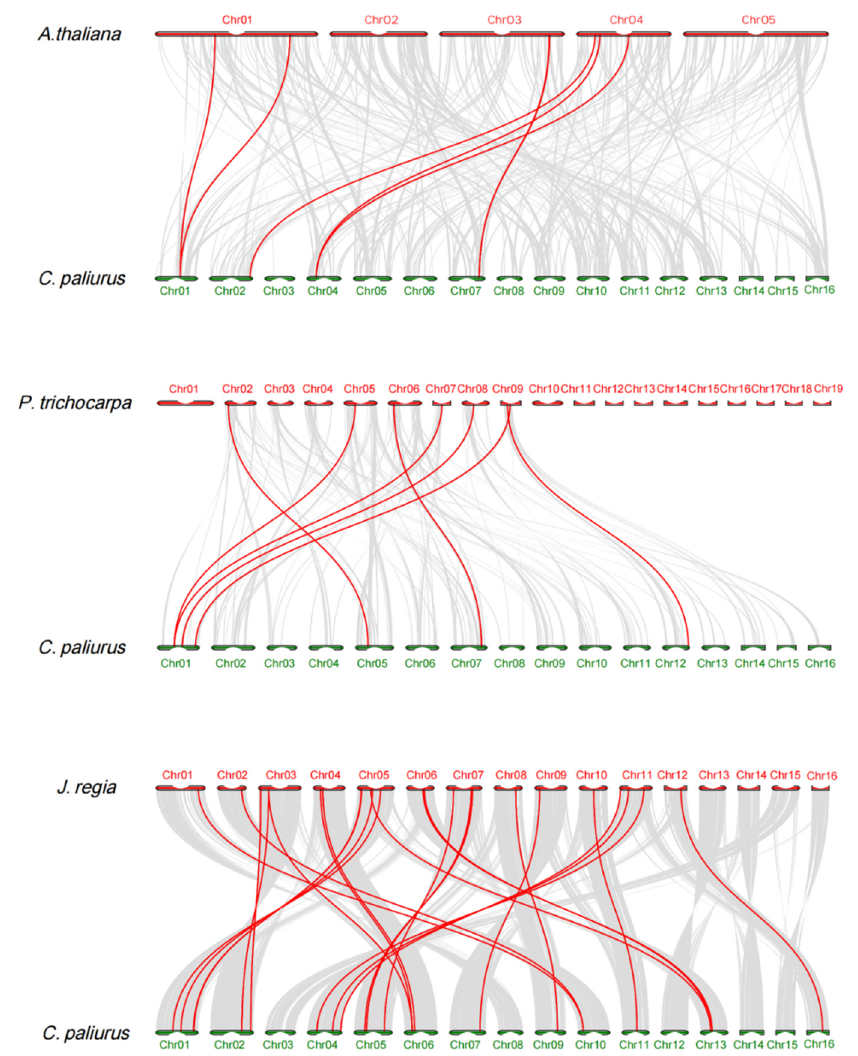
Figure 2. Synteny analysis of MIKC-type MADS-box genes between C. paliurus and three plant species. The collinear blocks between C. paliurus and other three plant genomes are shown as the gray lines in the background, while the syntenic MIKC-type MADS-box gene pairs are highlighted with red lines.